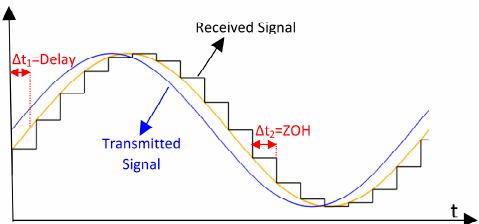
Figure 7. Simple waveforms of a transmitted signal and the corresponding received signal with its transmission delay ( Δ t 1 ) and ZOH ( Δ t 2 ) in an LB digital communication network [91].